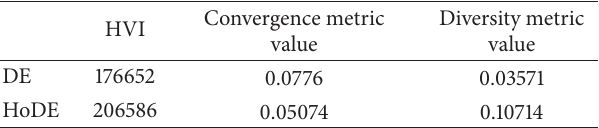
Table 5: The HVI, convergence, and diversity values produced by HoDE.